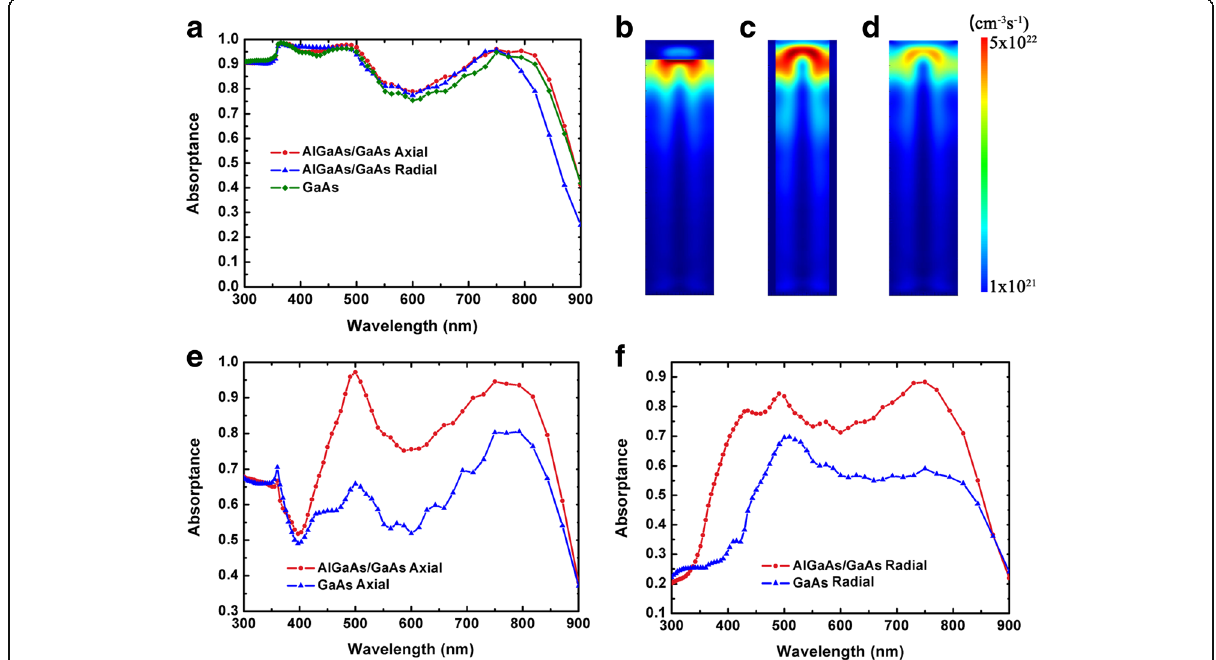
Fig. 2 a The absorption spectra of the GaAs nanowire and its AlGaAs/GaAs counterparts with axial and radial heterostructures. The vertical cross section of optical generation profiles in the b AlGaAs/GaAs axial heterostructure nanowire, c AlGaAs/GaAs radial heterostructure nanowire, and d